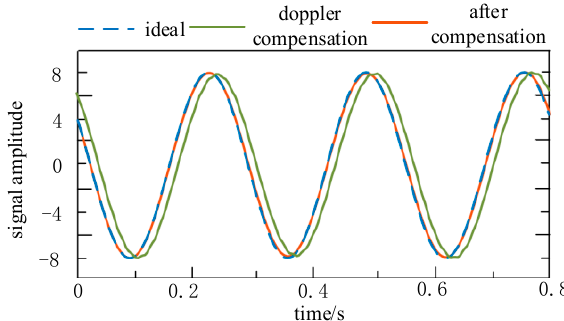
Figure 7. Comparison of phase compensation waveform before and after.